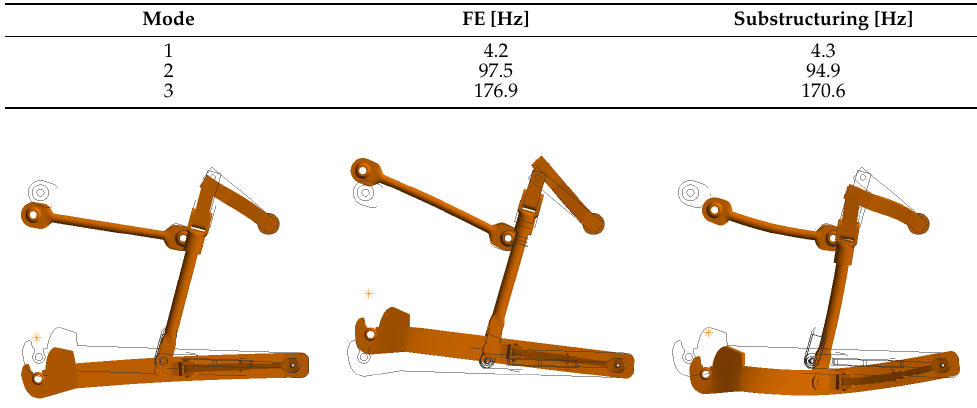
Table 3. Natural frequencies.